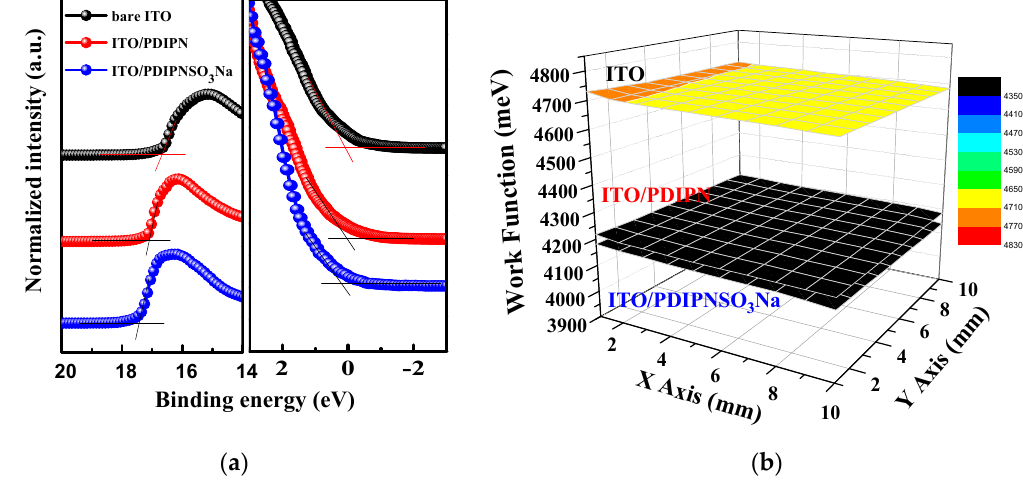
Figure 5. ( a ) Ultraviolet photoelectron spectroscopy (UPS) spectra of the inelastic cutoff region (left) and the HOMO region (right) of bare ITO, ITO/ PDIPN and ITO/ PDIPNSO 3 Na ETLs and ( b ) Work function images from Kelvin probe microscopy matrix. Table 1. Energy levels of the ITO, ITO/ PDIPN and ITO/ PDIPNSO 3 Na .